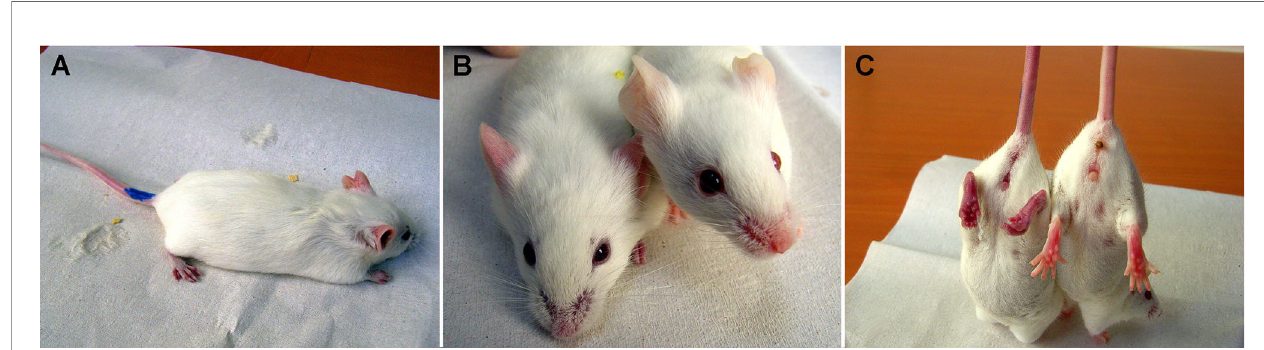
FIGURE 2 | Anaphylaxis in FVB/N mice prenatally exposed to ovalbumin. Gestational day 14 FVB/N fetuses were intraperitoneally exposed to free ovalbumin peptides. Postnatally, they received intraperitoneal ovalbumin re-challenge. (A) Within 10-15 minutes, mice developed limb weakness and (B) cyanotic nose, ears, (C) genitalia, feet and tail as compared with the normal control (right mouse). Subsequently, the mice presented with shallow breathing, and fi nally succumbed to anaphylaxis. Postnatal anaphylaxis indicated a prior sensitization event in fetal